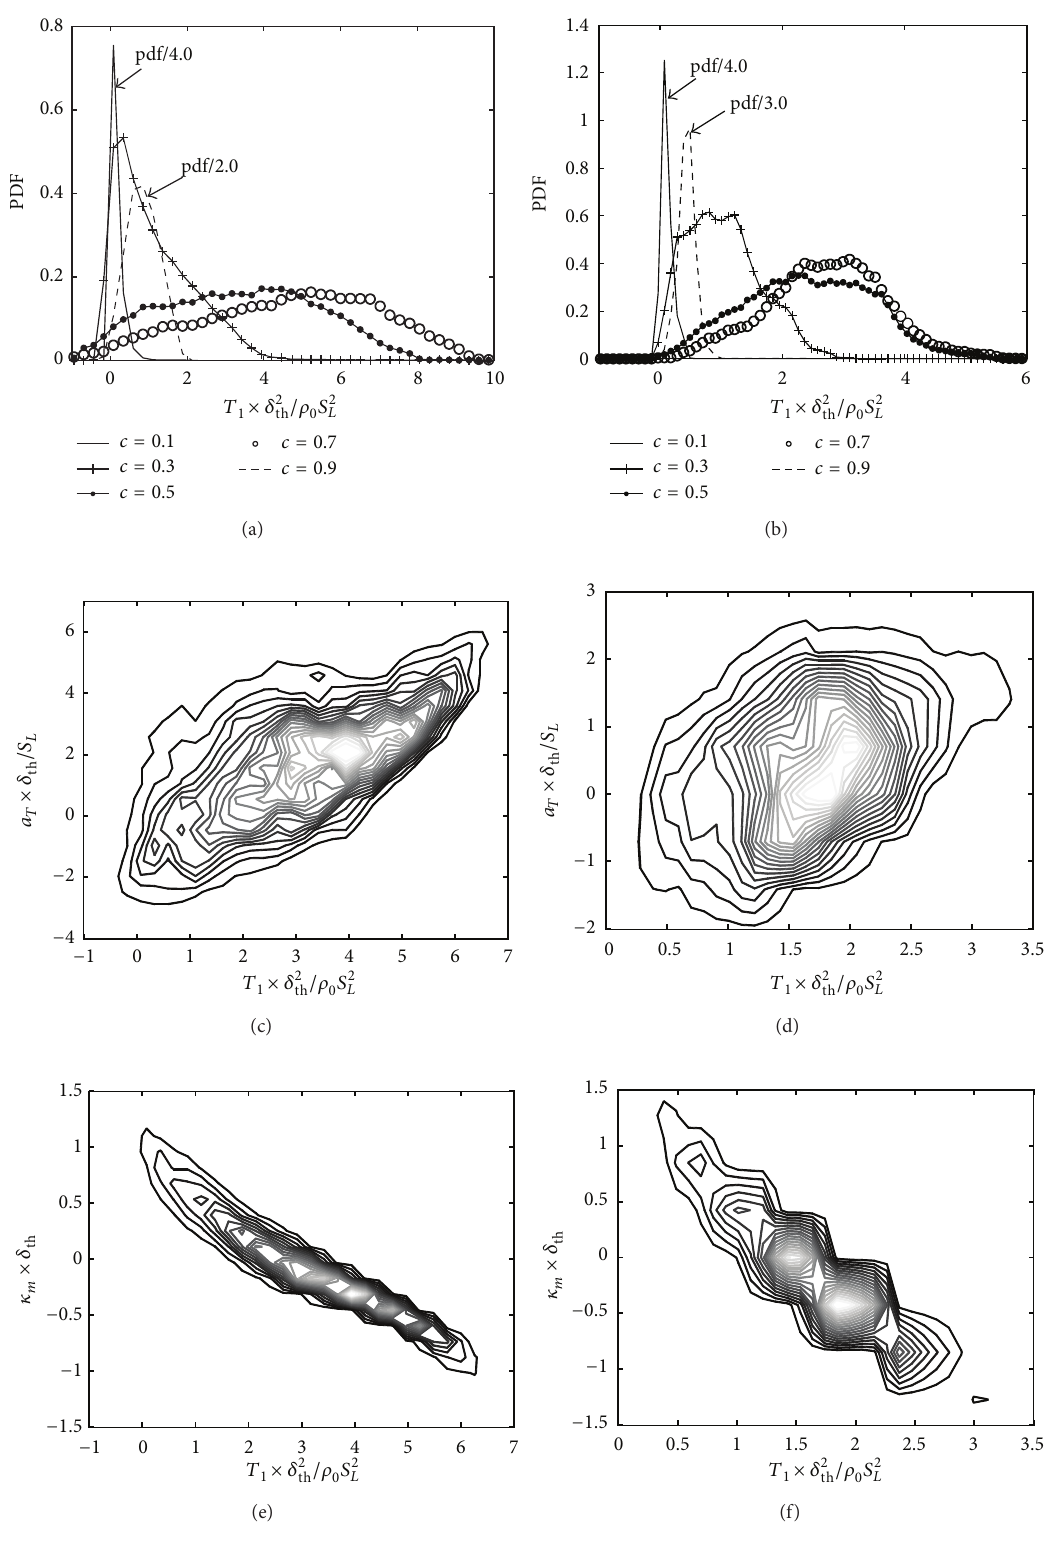
/𝜌 𝑆 2 𝑐 = 0.1 , 0.3, 0.5, 0.7, and 0.9 for cases (a) P3 and (b) V2. Joint pdf between 𝑇 0 𝐿 for th /𝑆 𝑐 = 0.8 isosurface for cases (c) P3 and (d) V2. Joint pdf between 𝑇 𝐿 on th